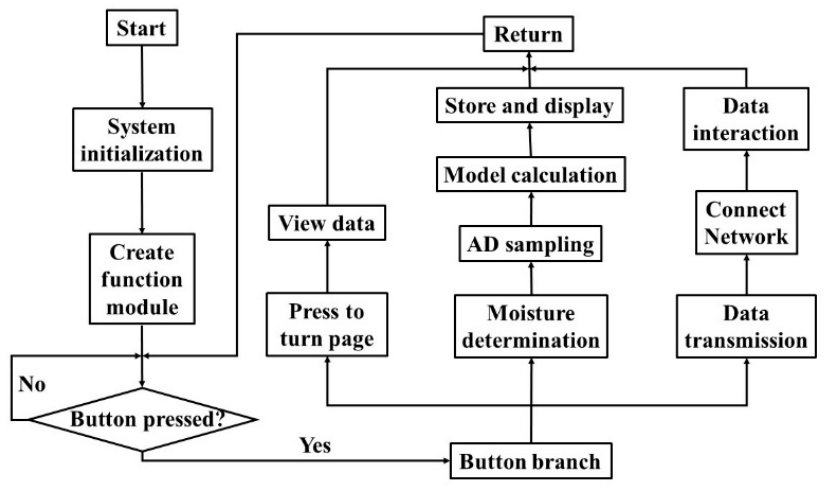
Figure 6. The flowchart of the software program.